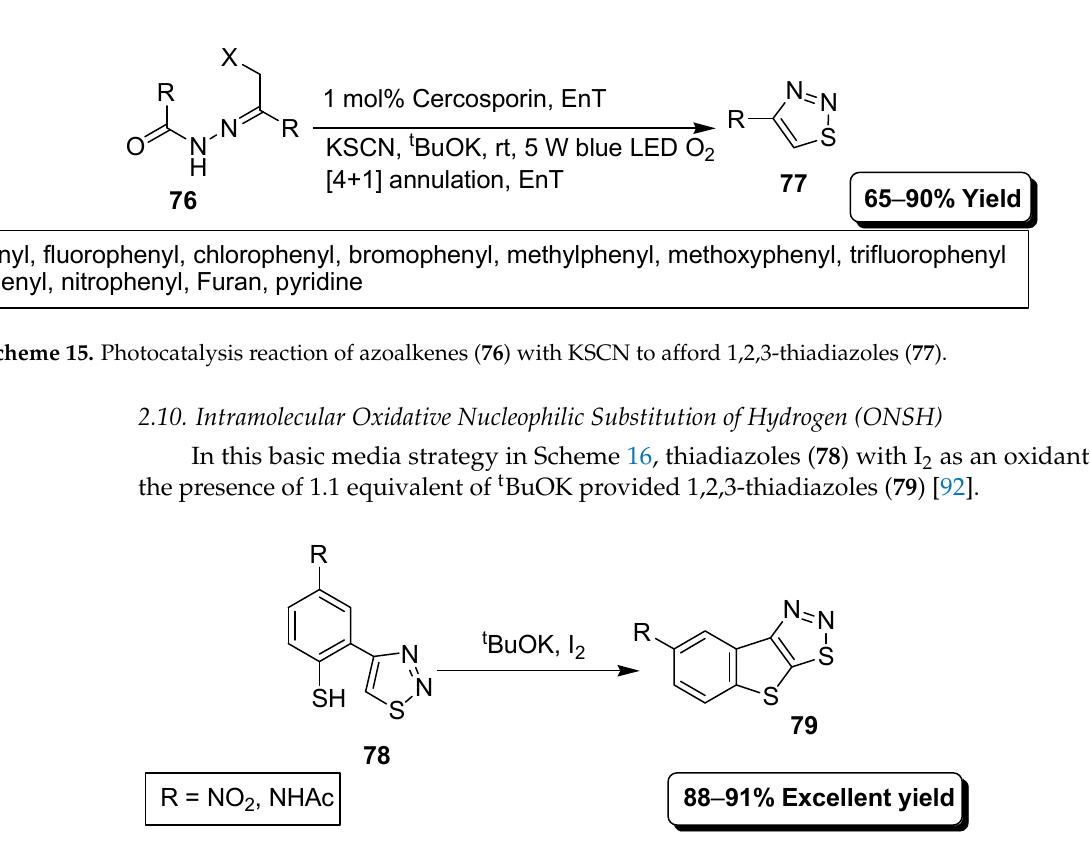
Scheme 16. Preparation of fused 1,2,3-thiadiazoles via ONSH mechanism. 2.11. Intermolecular [3+2] Heterocyclization